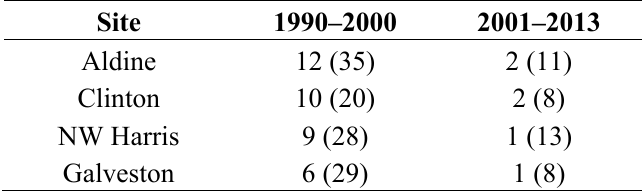
Table 1. Average Number of Exceedance Days per Site 1-h